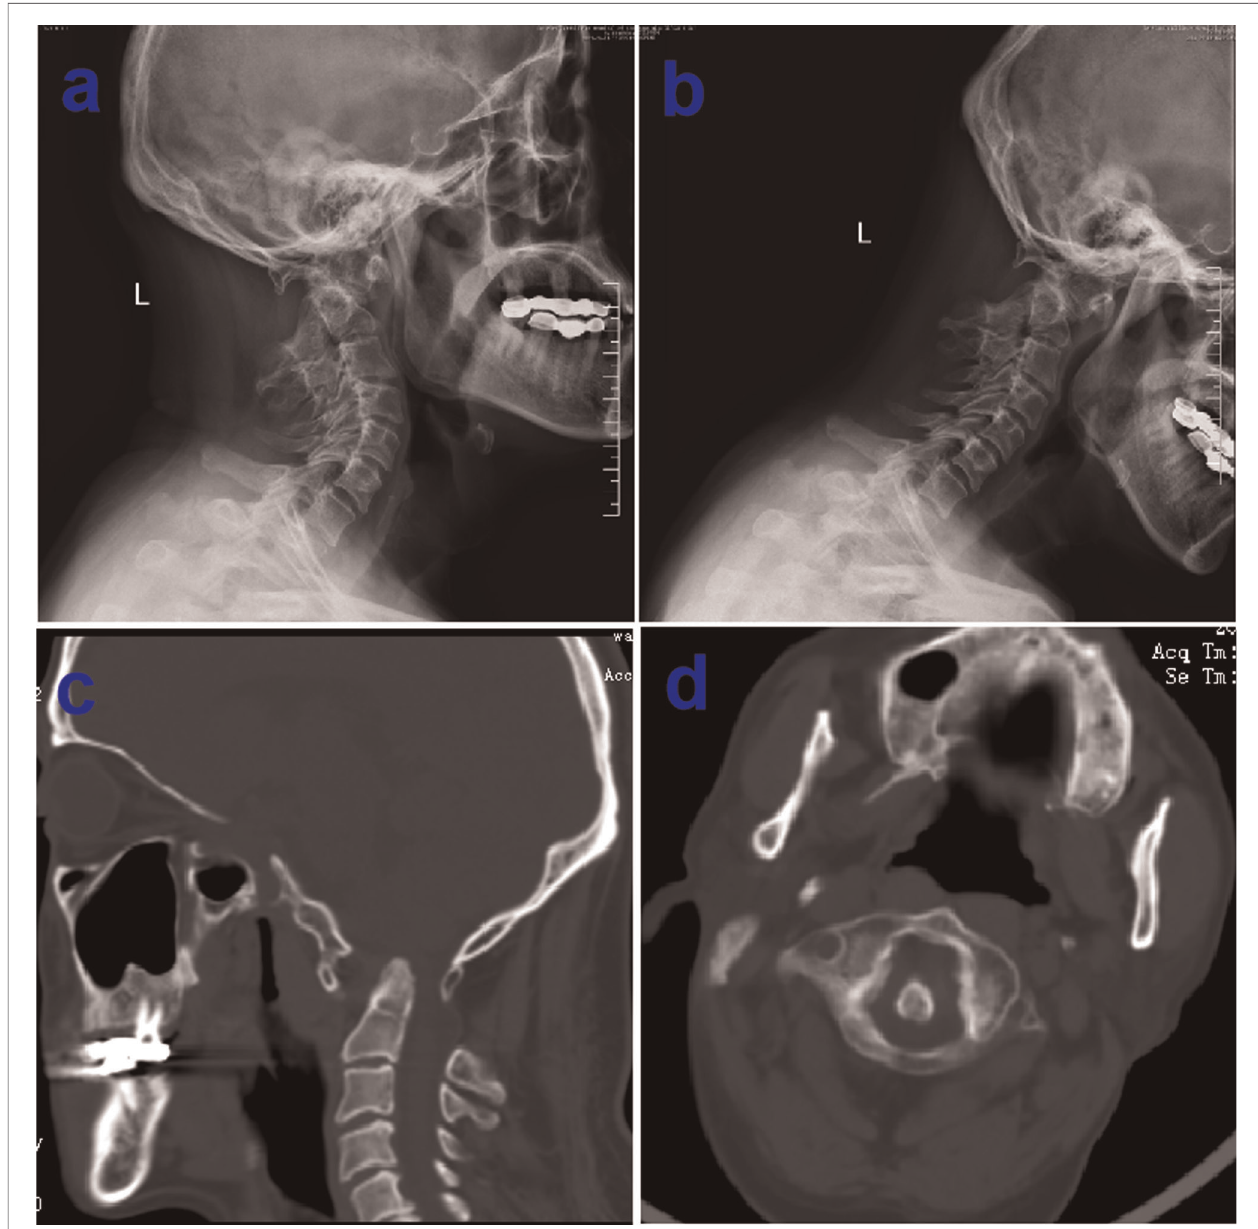
FIGURE 1 | Preoperative over-extension/ fl exion dynamic X-ray showing normal bone structure of atlantoaxial dislocation, basilar invagination and assimilation of atlas ( A and B ), computerized tomography (CT) examination con fi rm concomitant multiple bony abnormalities in the same patient ( C and D